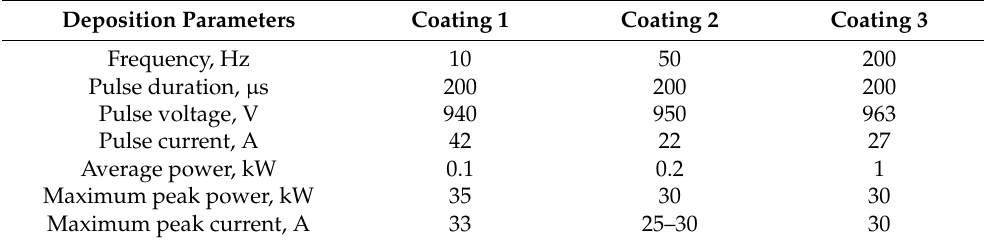
Table 1. Coating deposition parameters.